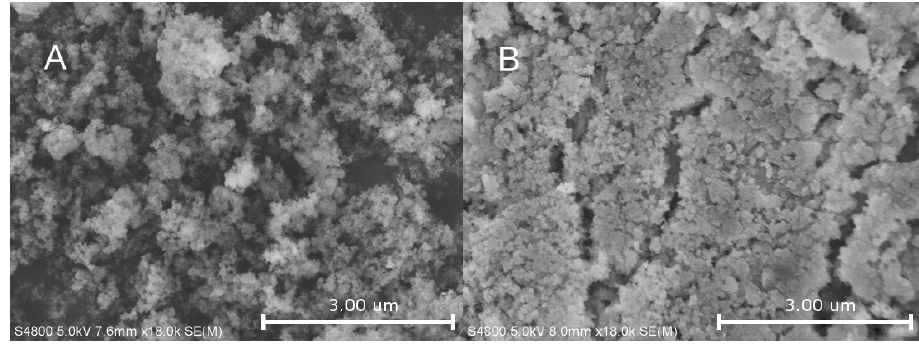
catalyst after ( A ) impregnation and ( B ) the 2